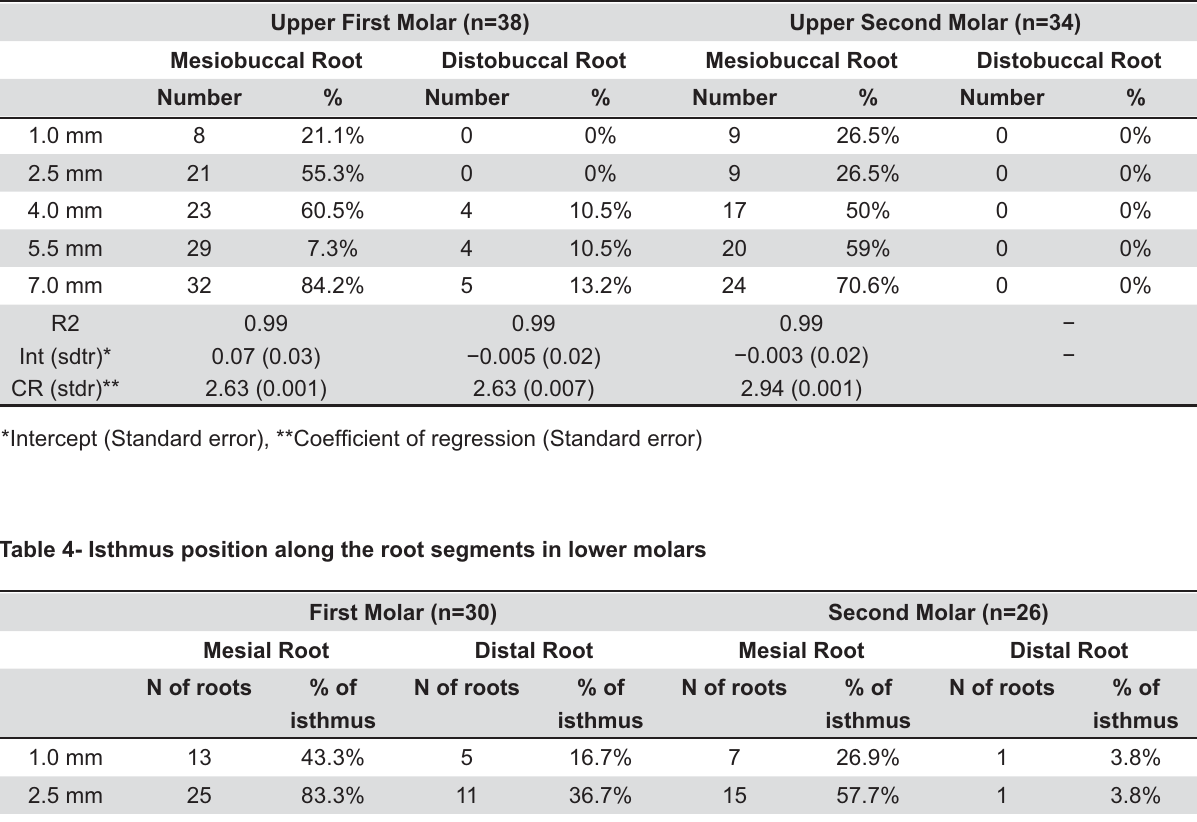
Table 3- Isthmus position along the root segments in upper molars